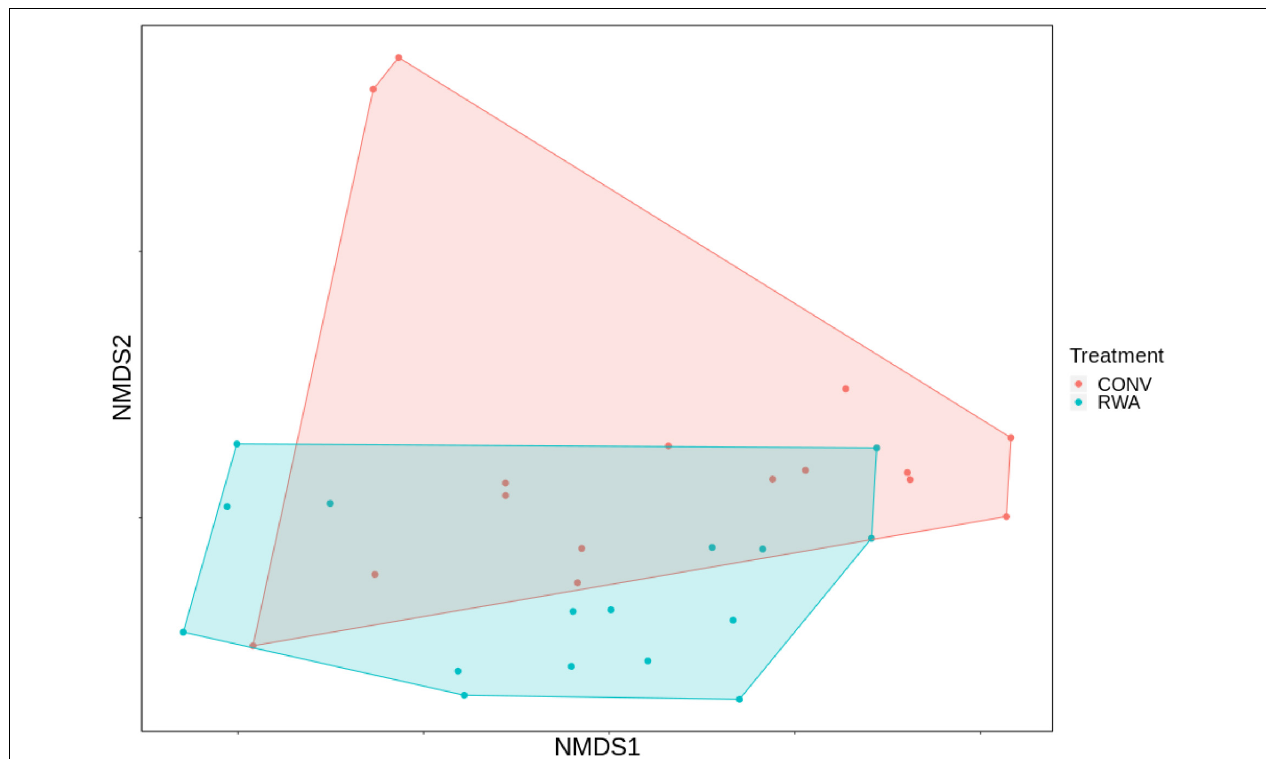
FIGURE 2 | Ordination comparing resistome composition at the AMR drug class level, using non-metric multidimensional scaling (NMDS), between labeling types on ground beef products; conventional (CONV) vs raised without antibiotics (RWA).